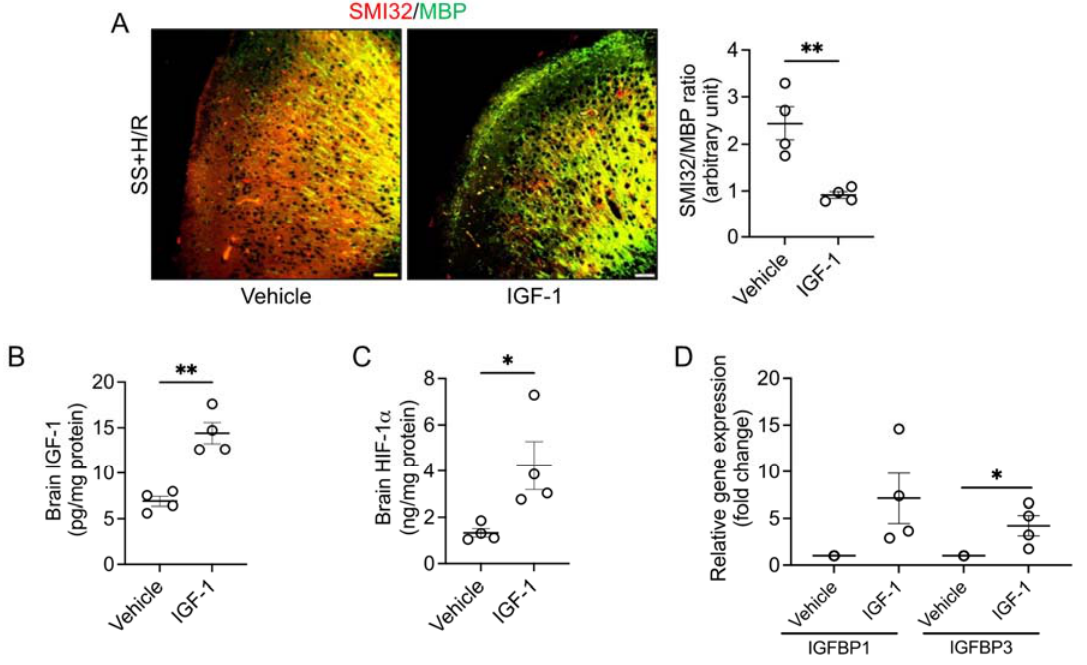
Figure 2. IGF-1 pretreatment protects sickle mice from H/R induced white matter injury. ( A ) The sickle mice (SS) were given subcutaneous injections of vehicle or human recombinant IGF-1 (50 µ g/kg) for 5 days followed by H/R. Representative microscopic images of SMI32 (red) and MBP (green) double-stained brain sections collected from vehicle or IGF-1 treated SS mice (scale bar = 50 µ m). The IGF-1 treated SS mice had reduced SMI32/MBP ratio indicating improved white matter integrity compared to vehicle-treated SS mice. ( n = 4) ( B ) IGF-1 pretreatment increased IGF-1 content in the brains of SS mice. ( n = 4) ( C ) HIF-1 α concentration in brain tissue homogenates from vehicle and IGF-1 treated SS mice. ( n = 4) ( D ) Relative expression of IGFBP1 and IGFBP3 genes isolated from brain tissues of vehicle or IGF-1 treated SS mice. ( n = 4) * p < 0.05 and ** p < 0.01.